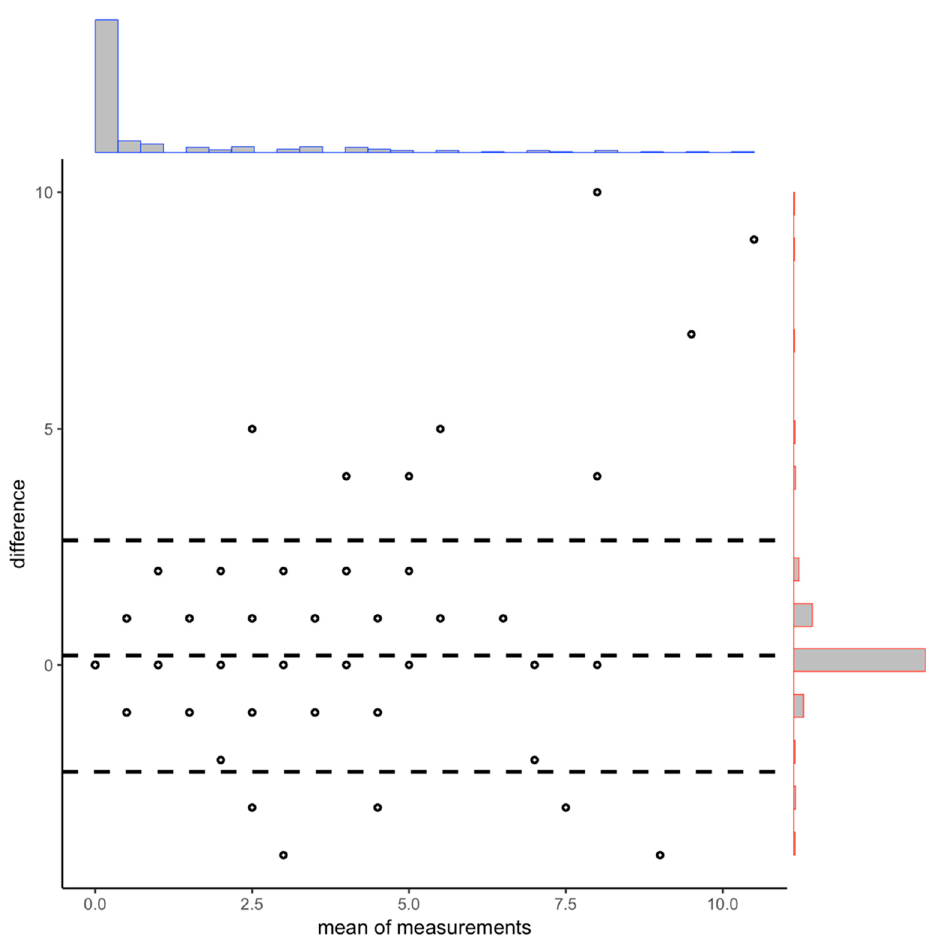
Figure 5. Bland and Altman diagram for the comparison of results obtained with FLC versus street audit.